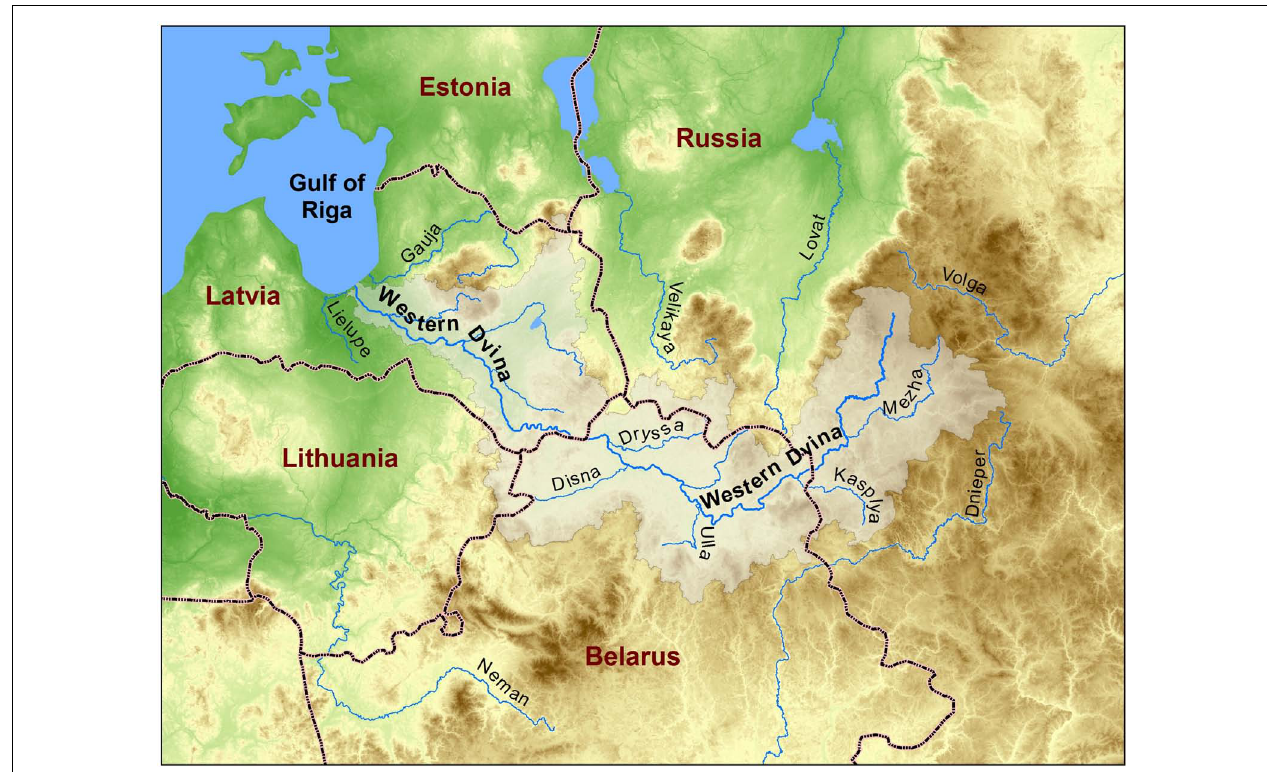
FIGURE 1 | Location of the study